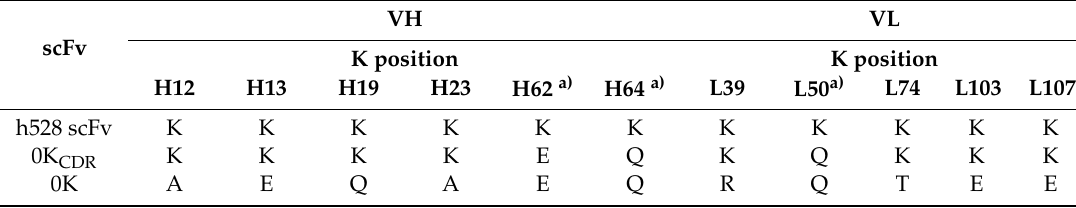
Table 1. Mutations of lysine residues in the h528 scFv.